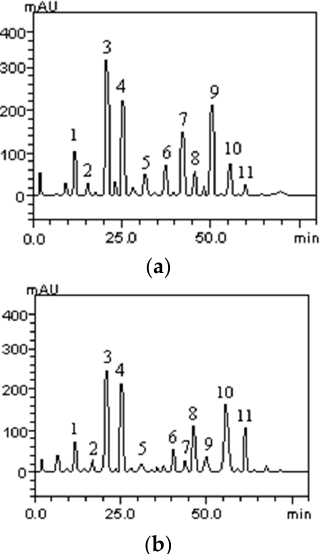
Figure 1. High performance liquid chromatography phenolics and flavonoids profile of L. tomentosa ethanolic extract ( a ) and L. rigida ethanolic extract ( b ). Gallic acid (peak 1), catechin (peak 2), chlorogenic acid (peak 3), caffeic acid (peak 4), epicatechin (peak 5), ellagic acid (peak 6), rutin (peak 7), quercitrin (peak 8), quercetin (peak 9), kaempferol (peak 10) and kaempferol glycoside (peak 11).